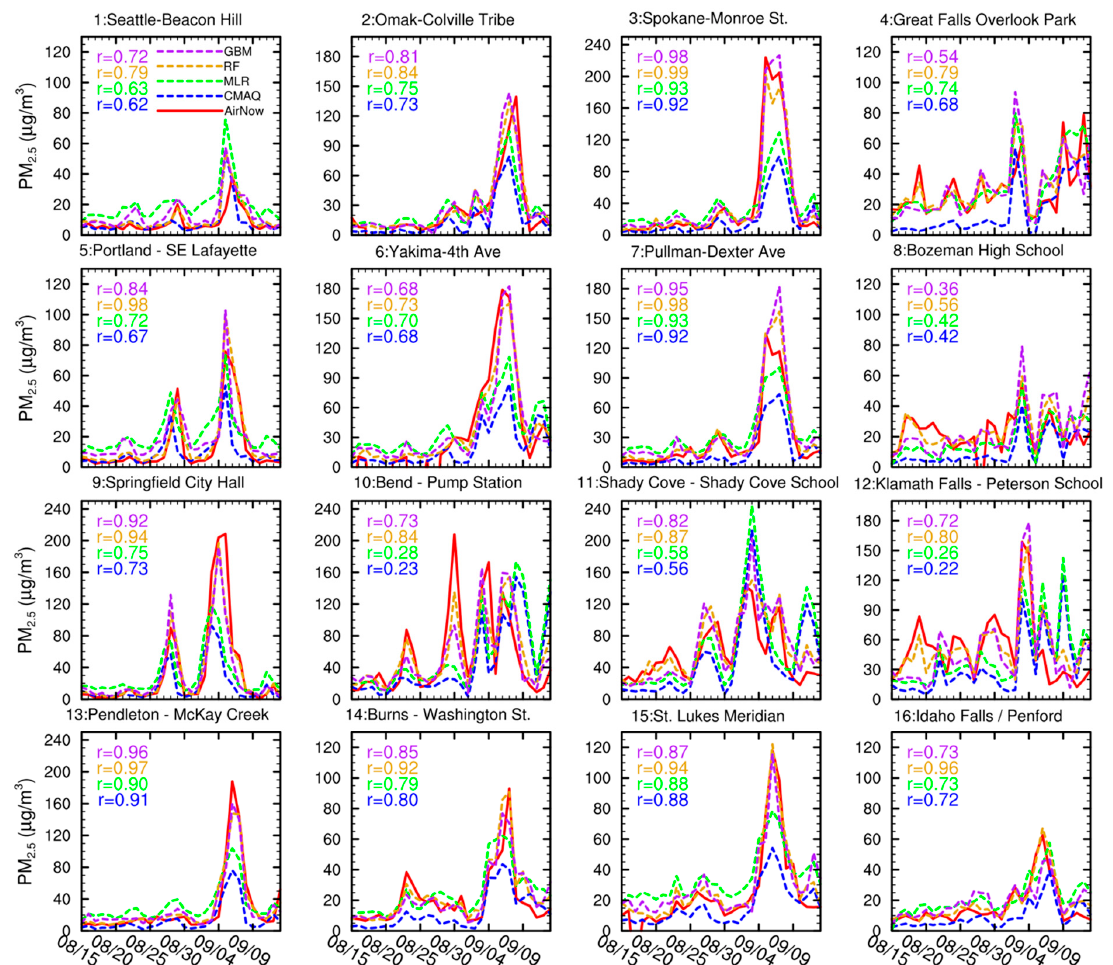
Figure 5. Time series of daily PM 2.5 concentrations at the 16 selected AirNow ground sites in Figure 4a. The red solid lines denote AirNow ground measurements. The blue dashed lines denote CMAQ simulation results. The green dashed lines denote the MLR results. The golden dashed lines denote the RF results. The purple dashed lines denote the GBM results. The numbers on top-left corners of each subplot denote temporal correlations between these model results and observations. MLR: Multi-linear